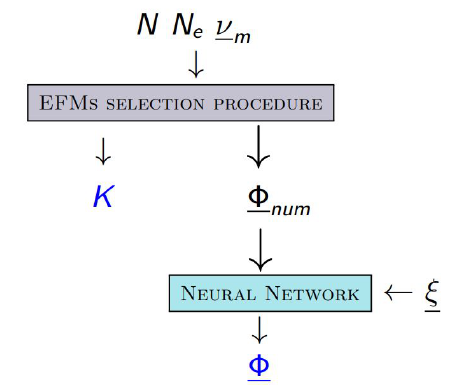
Figure 1. Hybrid modeling using an elementary flux mode reduction procedure and neural networks. N is the stoichiometric matrix, N e is the stoichiometric matrix of extracellular measurements, ν m is the vector of experimental uptake and excretion rates, K describes the stoichiometry of the bioreactions, φ is the vector of reaction rates obtained numerically from the reduction procedure, φ is the vector num of reaction rates modeled using NN and ξ is the vector of concentrations of culture